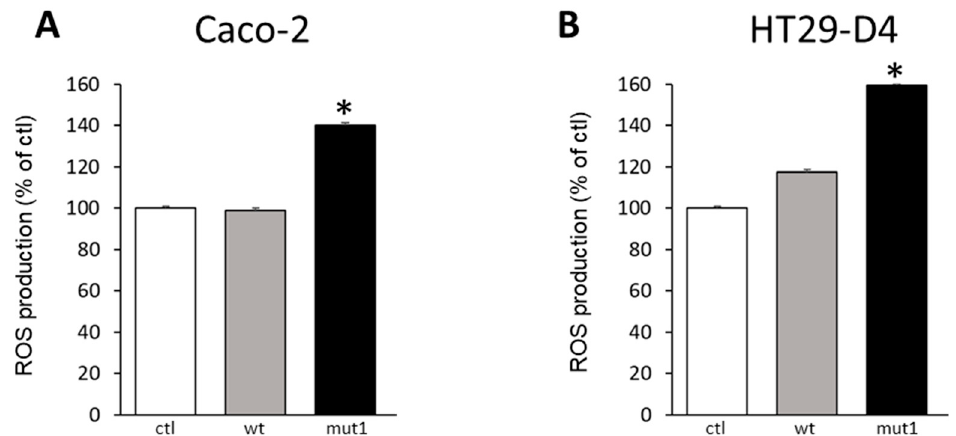
Figure 3. ROS production in Caco-2 and HT29-D4 cells overexpressing ctl, wt Noxo1-DDK or mut1 Noxo1-DDK. ( A , B ) Illustrate ROS production in Caco-2 and HT29-D4 cells overexpressing ctl, wt Noxo1-DDK, or mut1 Noxo1-DDK. Mut1 Noxo1 overexpression induced a significant increase